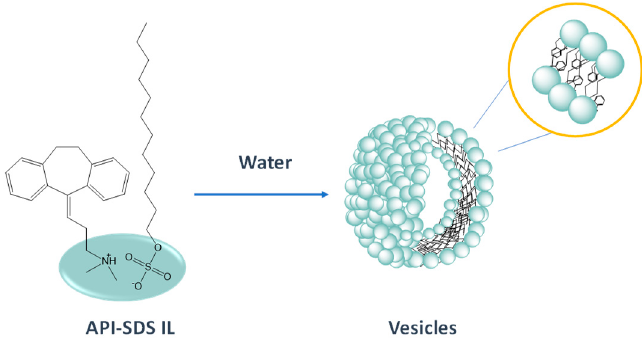
Figure 17. Illustration of the API-IL self-assembling into vesicles in aqueous media proposed in [191].